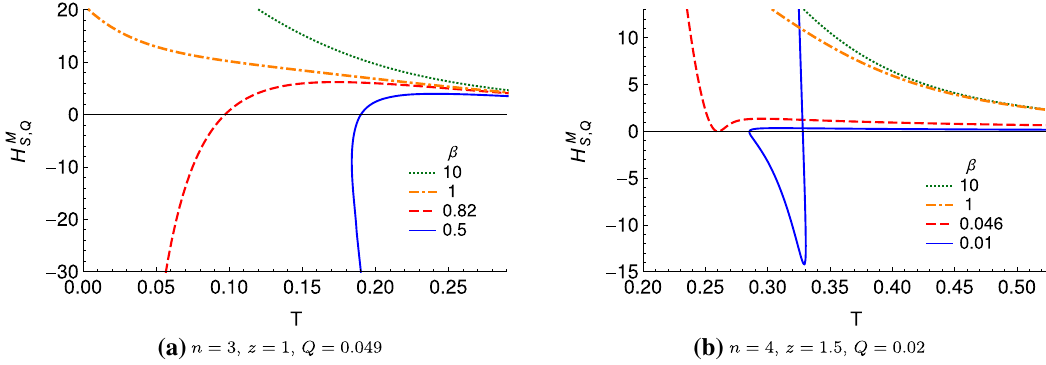
Fig. 9 The behavior of the determinant of the Hessian matrix H M